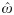
Influence of kinetic rates and cooperativity on oscillations.Peak frequency ω^ (panel A) and the quality factor Q90% (panel B) as a function of ϵ and λ, for oscillations in the number fluctuations of repressor. Red dots correspond to the parameter values used in Figs 2 and 3, where λ = 1. See details of the plot near λ = 1 in S1 Fig.